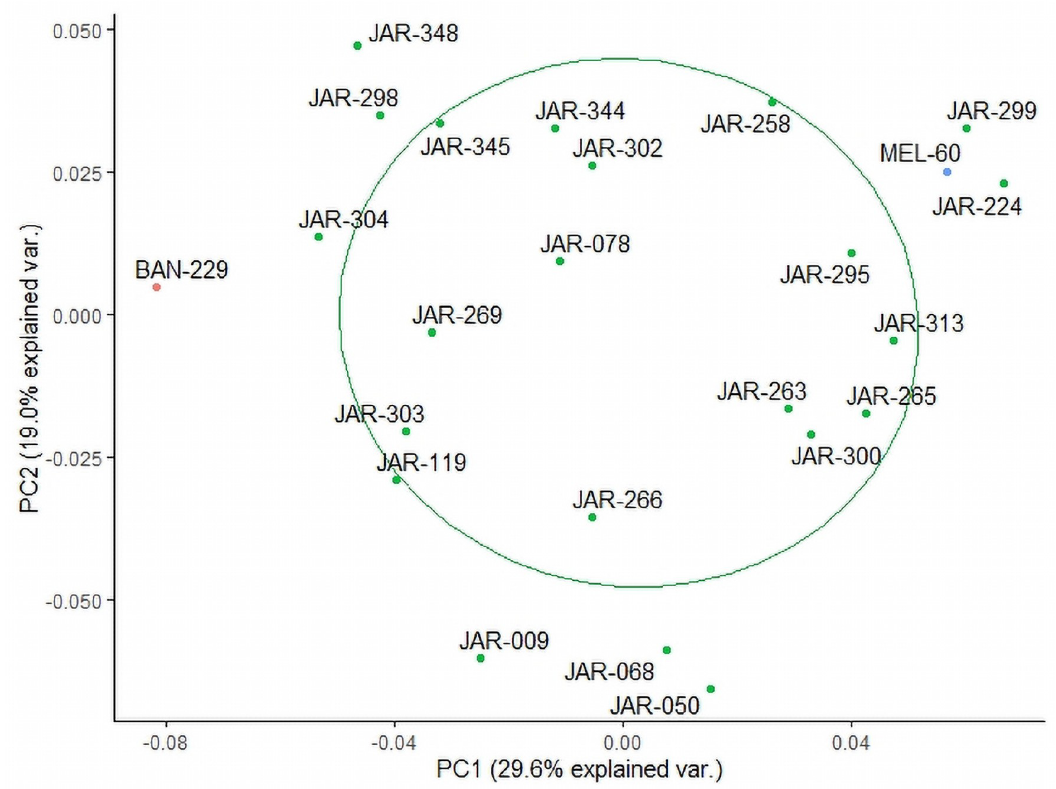
Fig 4. Final step of cluster analysis (identification of refined JAR core